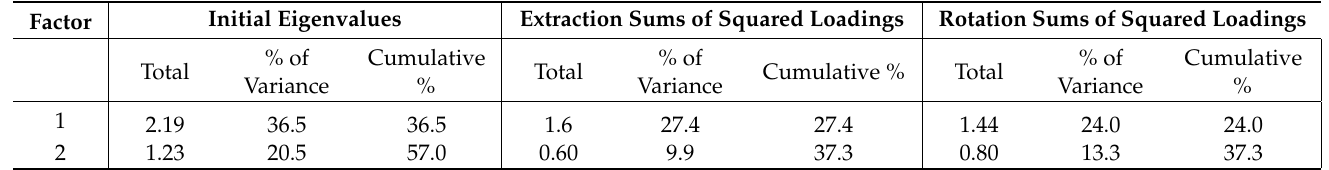
Table 3. Eigenvalues and the cumulative percentage explained by the factors.